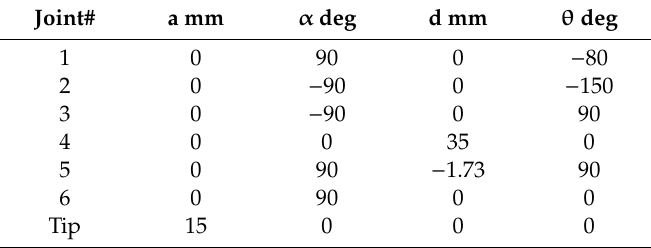
Table 6. Denavit–Hartenberg (DH) parameter of Condition (C).